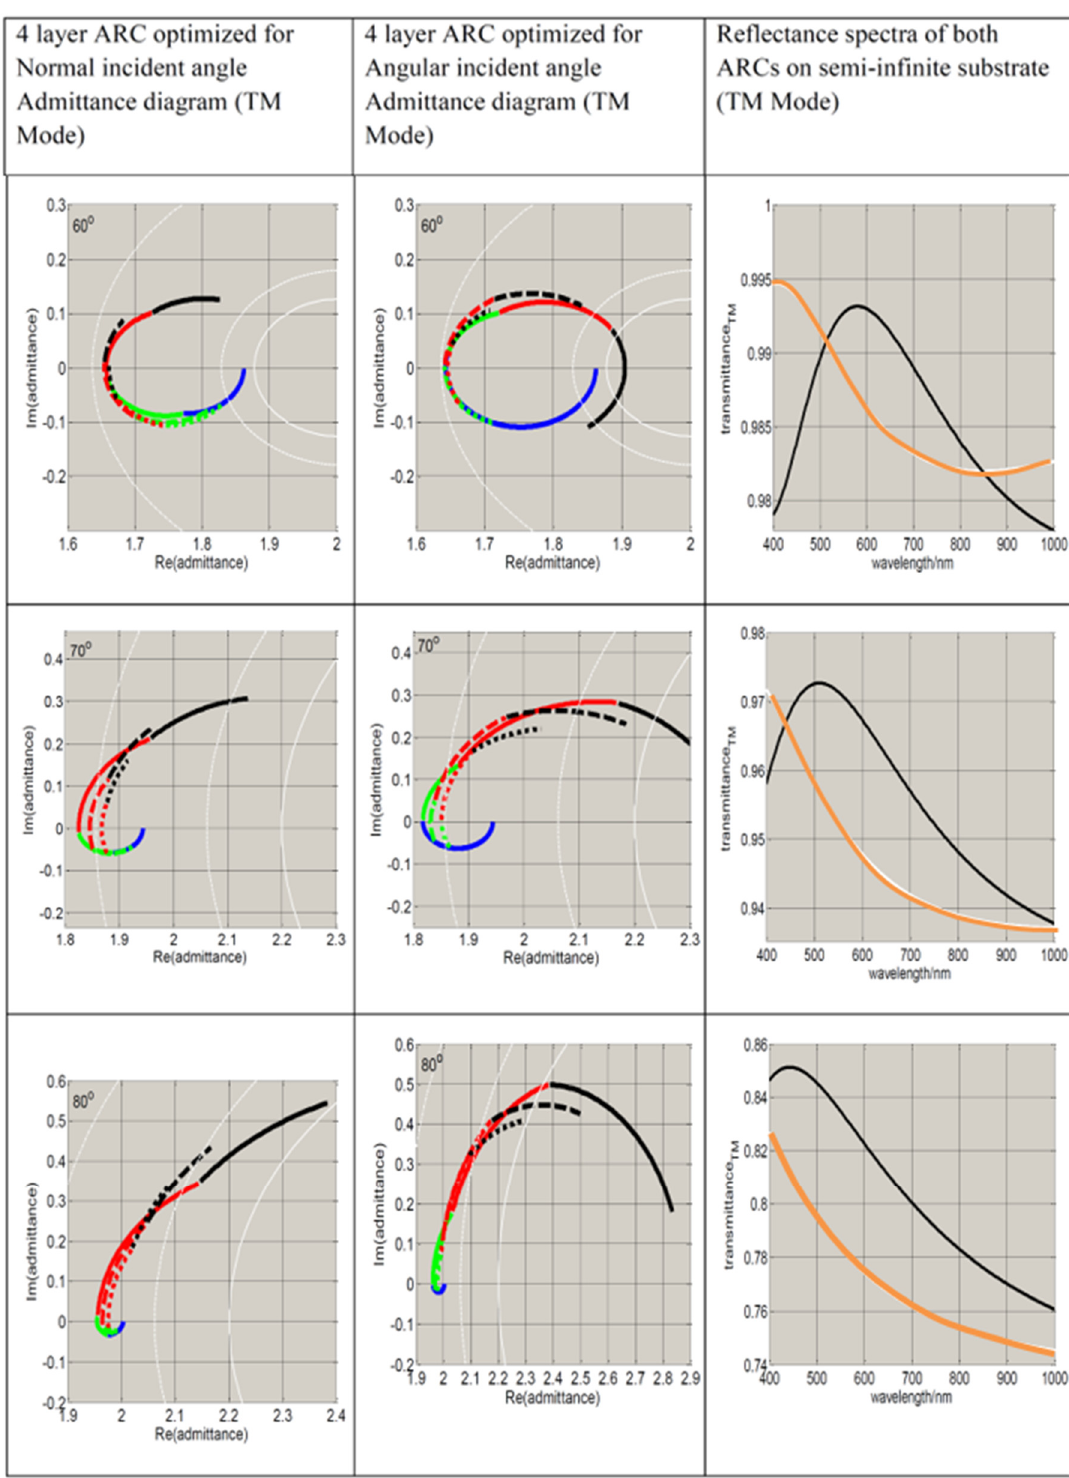
Figure A1. Admittance loci for the normal incidence optimized and angular incidence optimized ARC designs for TM mode. The TM transmittance spectra for these designs on a semi ‐ infinite glass substrate are also shown. The admittance loci representations are shown for increasing angles of incidences from 0° to 80°.